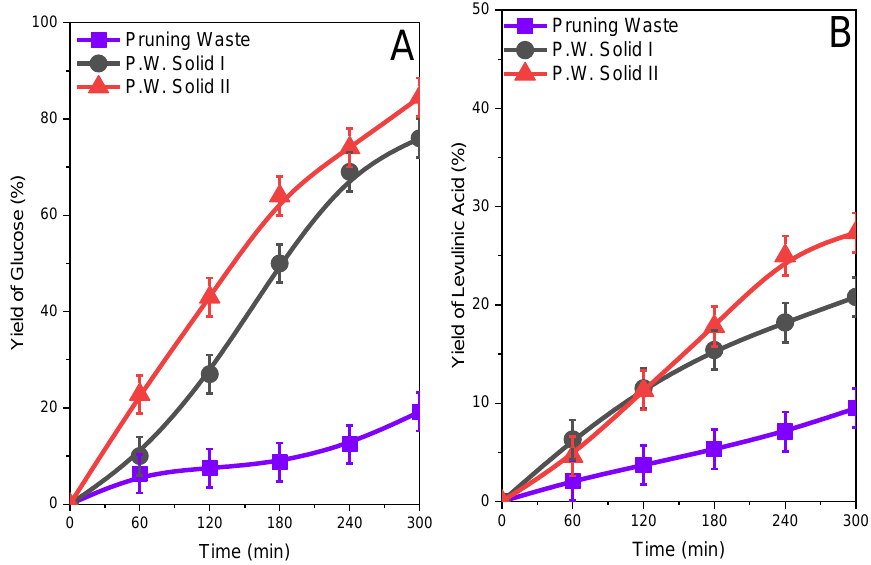
Figure 7. Glucose ( Graph A ) and levulinic acid ( Graph B ) yields after the hydrolysis of the original pruning waste and pruning waste solids obtained (Solid I and Solid II) after treatment with ISH.